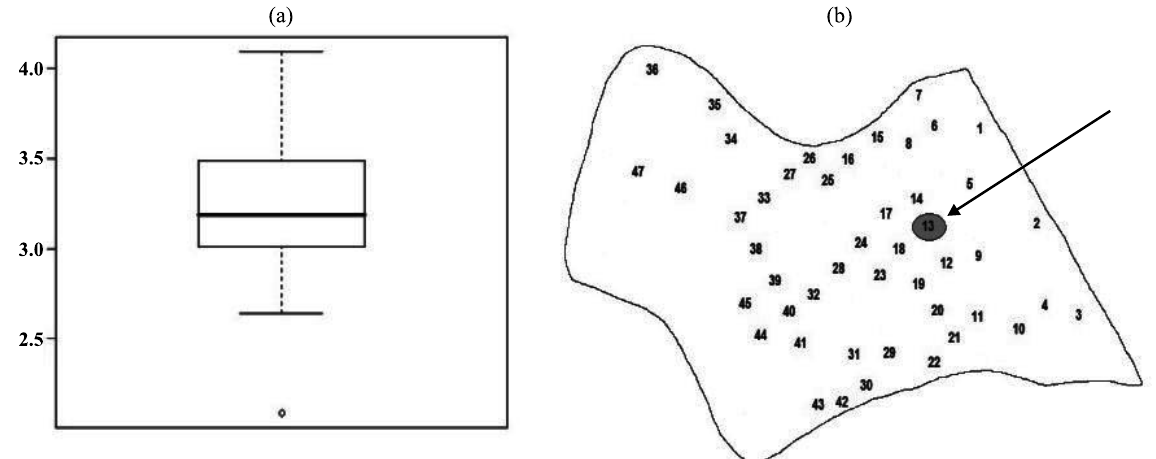
Figure 1. (a) Box-plot graph of soybean yield and (b) Sketch of experimental